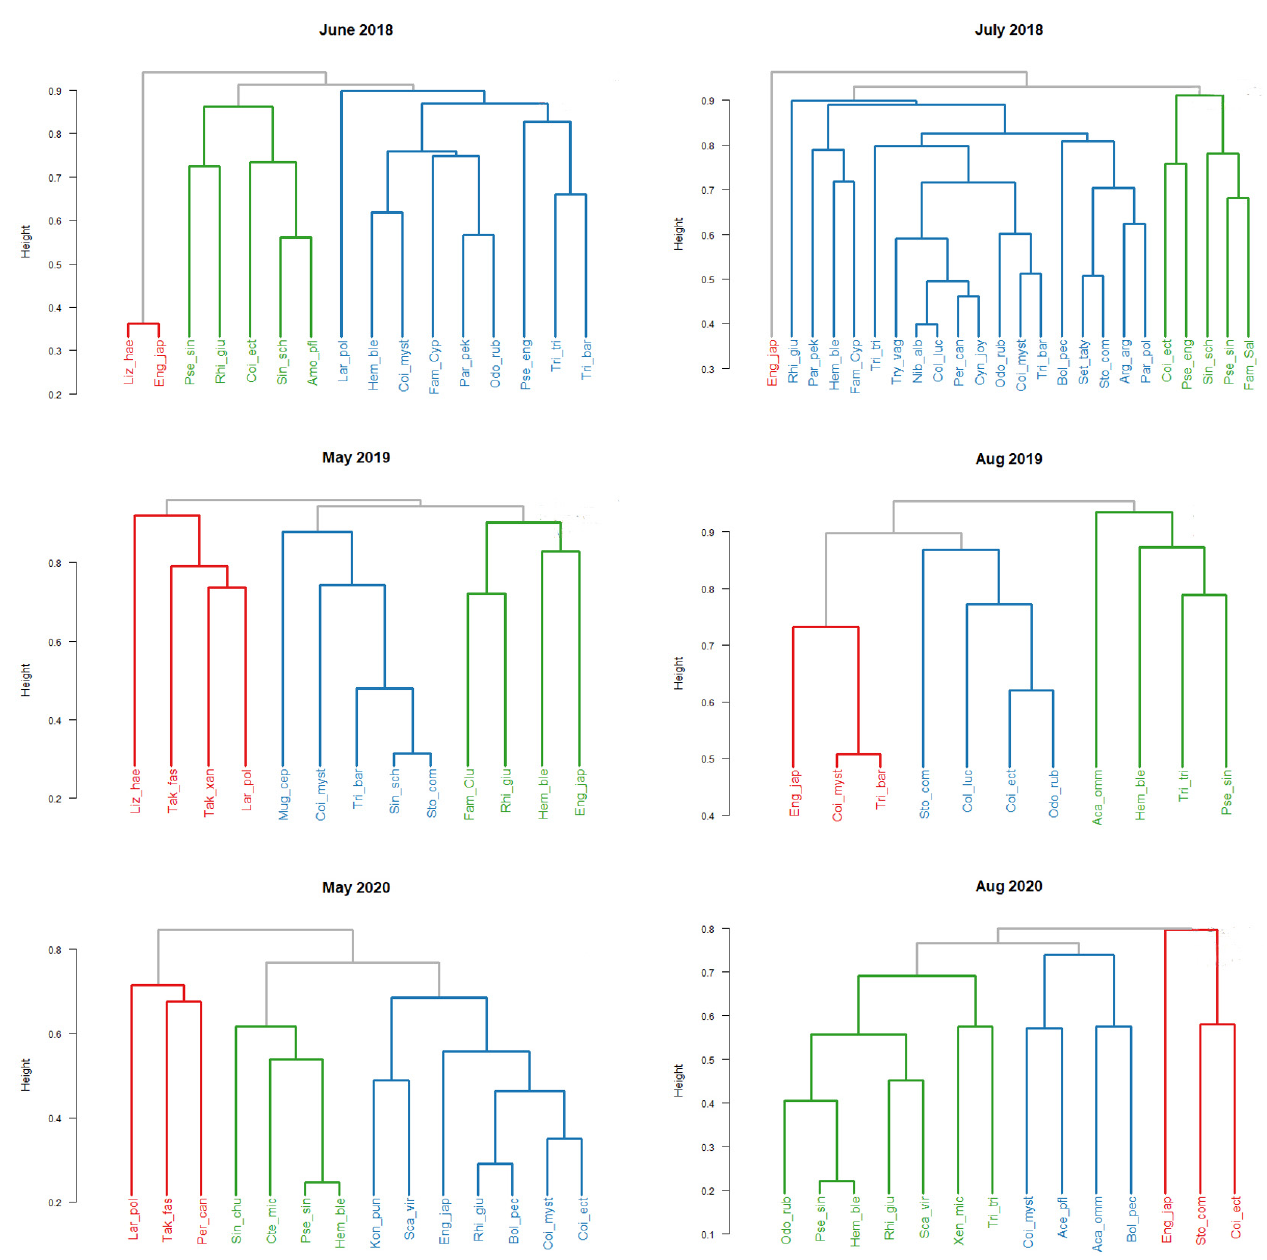
Figure 3. Hierarchical clustering for the species with occurrence >5% in each cruise (blue: b rackish water; green: freshwater; red: water; green: freshwater; red: marine).